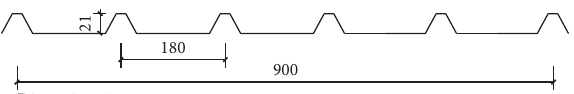
Figure 2: Arrangement diagram.